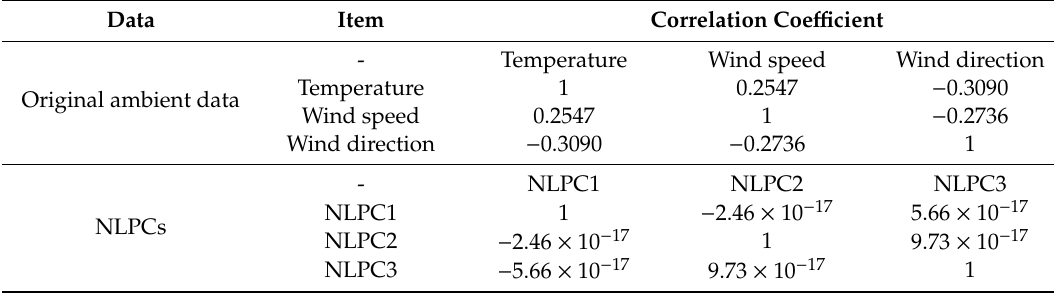
Table 1. Correlation coe ffi